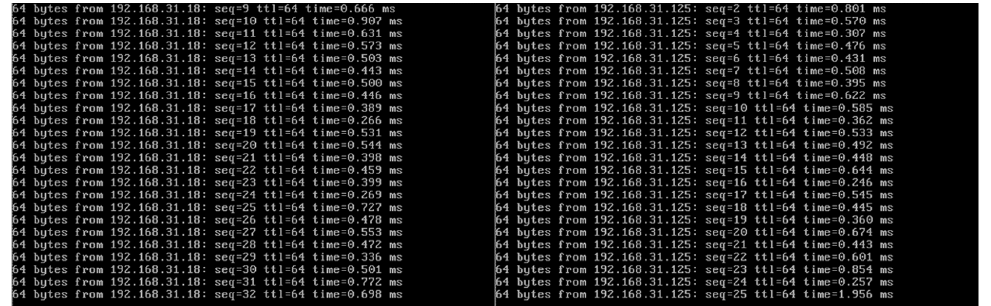
Figure 8. Real traffic flows between two ports of two different nodes.